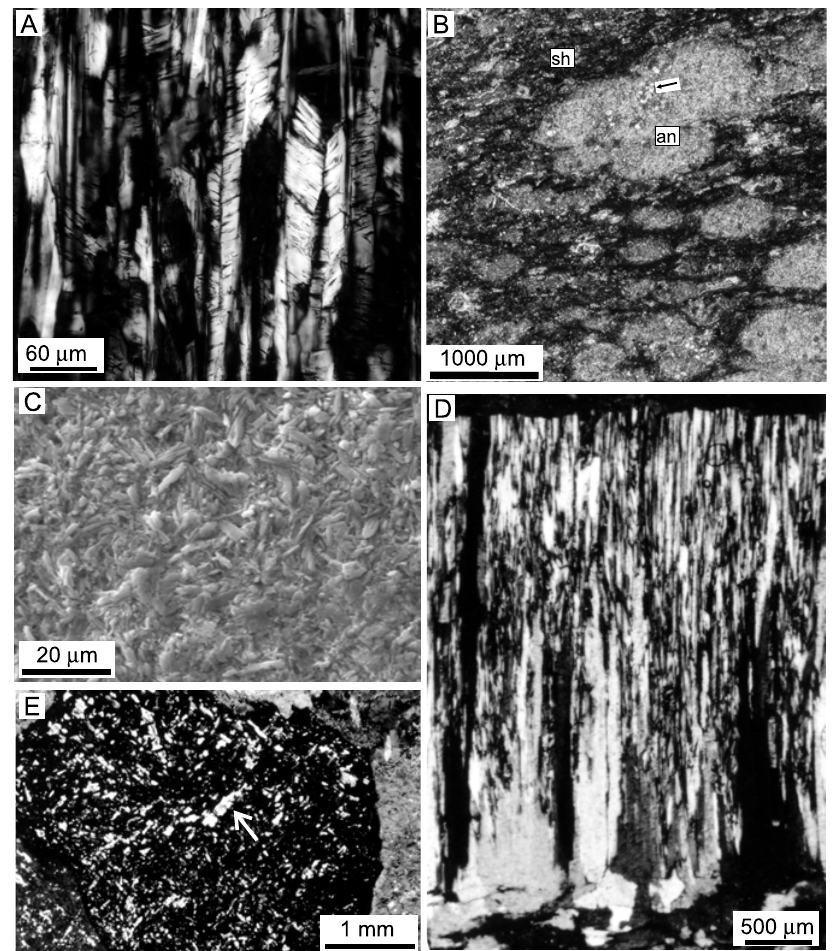
Fig. 6 – Textures of the evaporites from the Codó Formation exposed in the study areas. A) Chevron gypsum. B) Nodular gypsum (na) within bituminous black shales (sh). Note calcite relicts (arrow) within nodules (crossed polars). C) A close-up of the gypsum nodules shown in figure B, illustrating their composition by micrometric, equant, lath-like crystals, typical of anhydrites. D) Acicular gypsum and, at the base, mosaic gypsum. E) Relics of anhydrite (arrow) within a large mosaic gypsum crystal. (Except for figure B, all the other figures are SEM